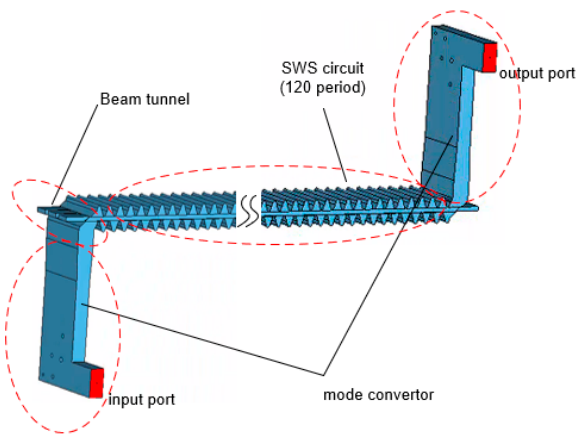
Figure 8. Vacuum model of TWT circuit using MBSC-SWG-SWS.